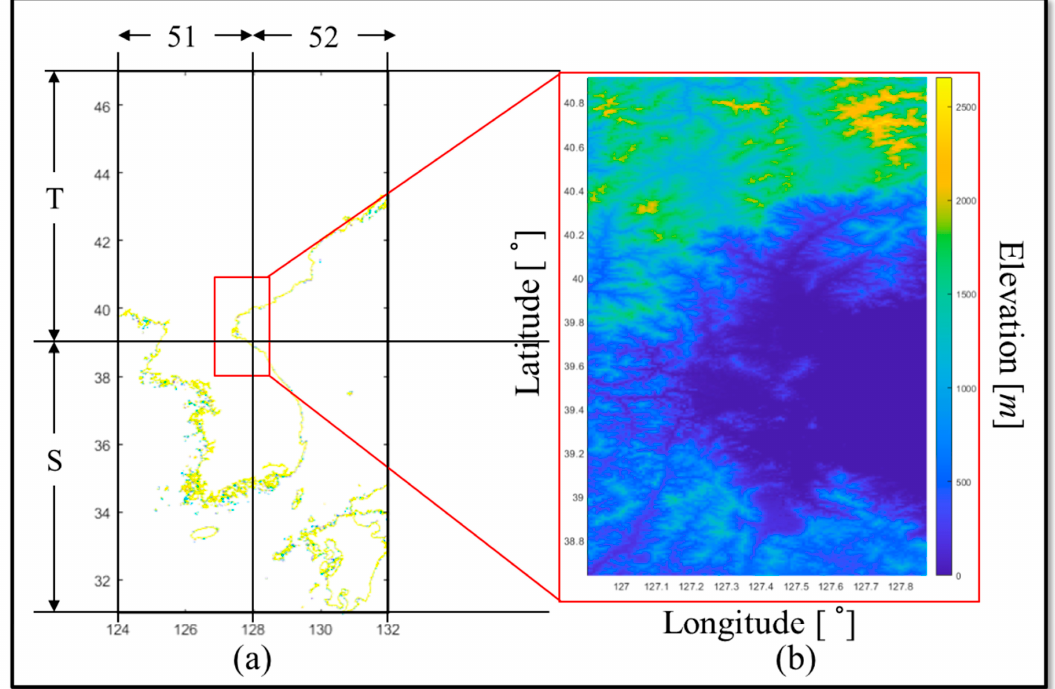
Figure 3. ( a ) Korean Peninsula in the Universal Transverse Mercator (UTM) coordinate system; ( b ) Elevation representation using the DTED level 0.